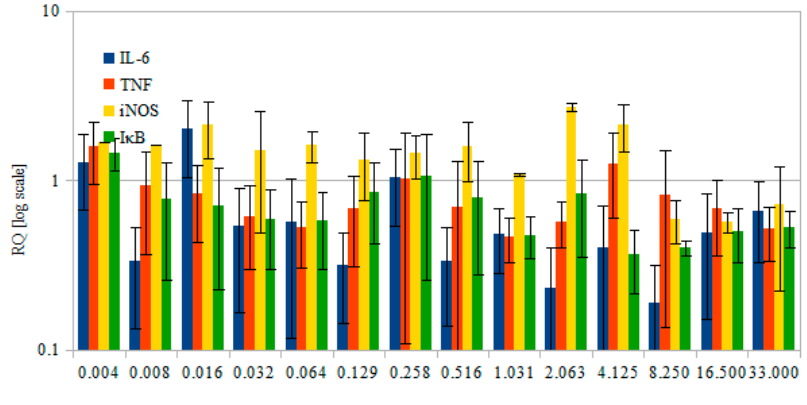
Figure 6. Relative quantity of selected cytokines produced by RAW 264.7 cells after 4 h of incubation with various concentrations of the protein of interest (scFvD 2 –5-Ht1A). Logarithmic scale. Errors were estimated using the standard deviation calculated from three separate experiments. IL-6, interleukin 6; TNF, tumor necrosis factor; iNOS, inducible nitric oxide synthase; I κ B, inhibitor of the NF κ B transcription factor.